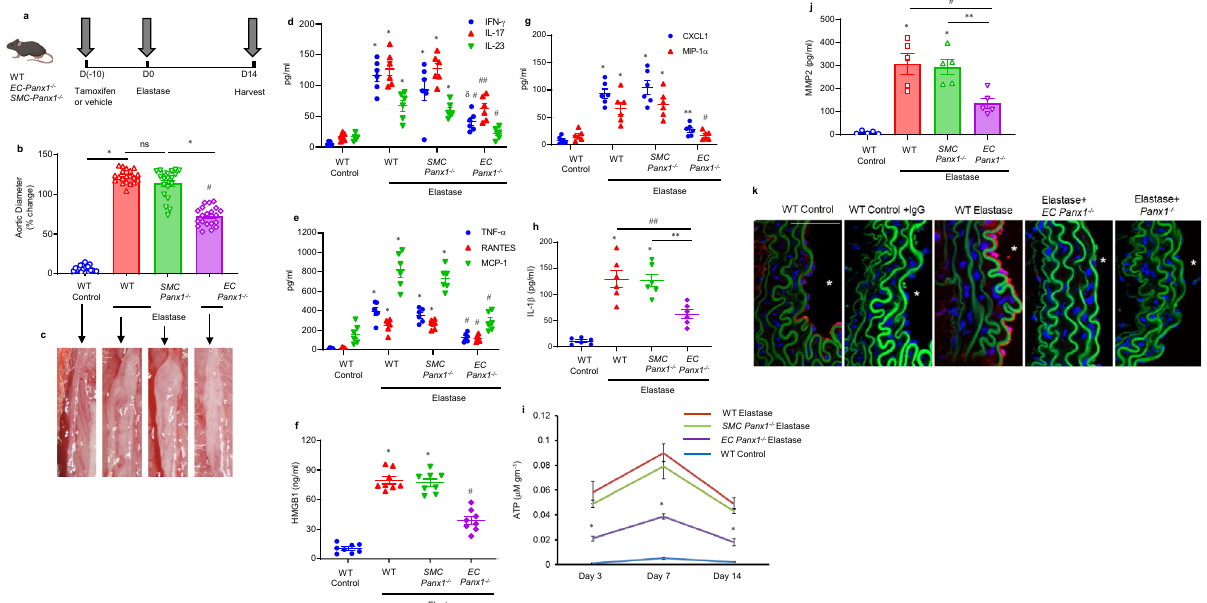
Fig. 1 Panx1 on endothelial cells regulates AAA formation and vascular in fl ammation. a Schematic description of the topical elastase-treatment model is shown. Inducible knockout male mice were treated with tamoxifen for 10 days prior to elastase treatment. WT or inducible knockout male mice were then treated with topical elastase, or heat-inactivated elastase (control), on day 0, and aortic diameter was measured on day 14. b Aortic diameter is signi fi cantly reduced in elastase-treated EC-Panx1 − / − , but not SMC-Panx1 − / − mice, compared with elastase-treated WT mice. * P < 0.0001; # P < 0.0001 vs. WT elastase; ns, P = 0.09; n = 20 mice/group. c Representative images of aortic phenotype in all groups. d – h Pro-in fl ammatory cytokine expression in aortic tissue is signi fi cantly attenuated in elastase-treated EC-Panx1 − / − , but not SMC-Panx1 − / − mice, compared with elastase-treated WT mice. * P < 0.0001 vs. WT control; # P = 0.0004 vs. WT elastase; δ P = 0.01 vs. SMC-Panx1 − / − elastase; ## P = 0.001 vs. WT elastase and SMC-Panx1 − / − elastase; ** P = 0.002 vs. SMC-Panx1 − / − elastase; n = 6/group. i Aortic tissue content of ATP was signi fi cantly attenuated in elastase-treated EC-Panx1 − / − , but not SMC-Panx1 − / − mice, compared with elastase-treated WT mice on days 3, 7, and 14. * P < 0.008 vs WT elastase and SMC-Panx1 − / − elastase; n = 5/ group. j Expression of MMP2 in aortic tissue was signi fi cantly attenuated in elastase-treated EC-Panx1 − / − mice compared with elastase-treated WT and SMC-Panx1 − / − mice. * P < 0.0001 vs. WT control; # P = 0.005 vs. WT elastase and **P = 0.01 vs. SMC-Panx1 − / − elastase; n = 5/group. All data above are represented as mean values± SEM and comparative statistical analyses were done by one-way ANOVA followed by multiple comparisons. k Aortic tissue from elastase-treated WT mice demonstrated a marked increase in Panx1 expression on day 14 compared with elastase-treated EC-Panx1 − / − mice. * : lumen; red: Panx1; green: elastic lamina and blue, blue: DAPI. Scale bar is 50 μ m; n = 5/group. Representative images from independent experimental replicates are